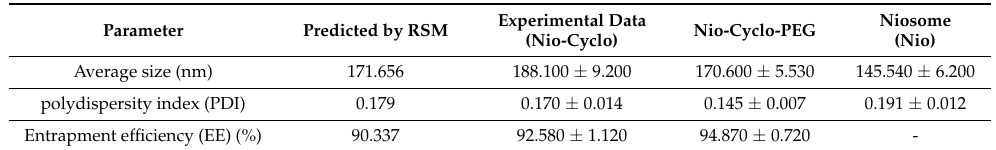
Table 5. The optimized values for the three responses obtained by RSM and the experimental responses under optimum